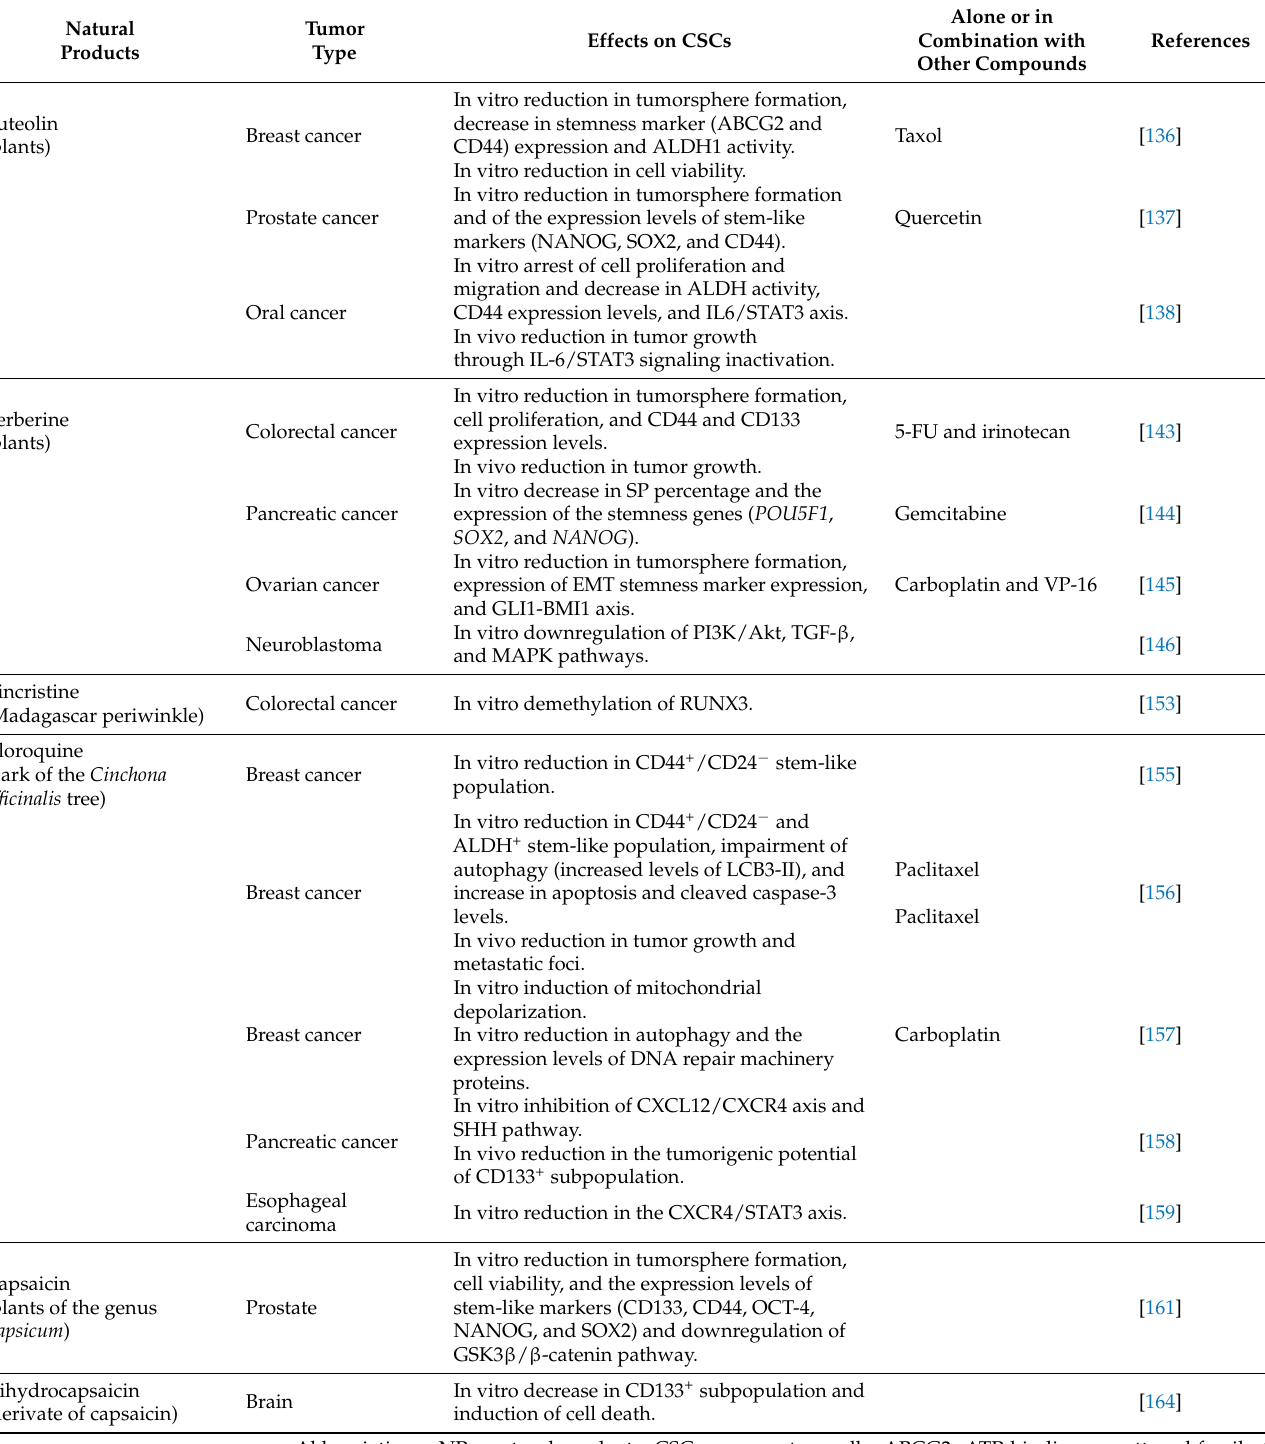
Table 2. NPs derived from botanical sources and their effects on